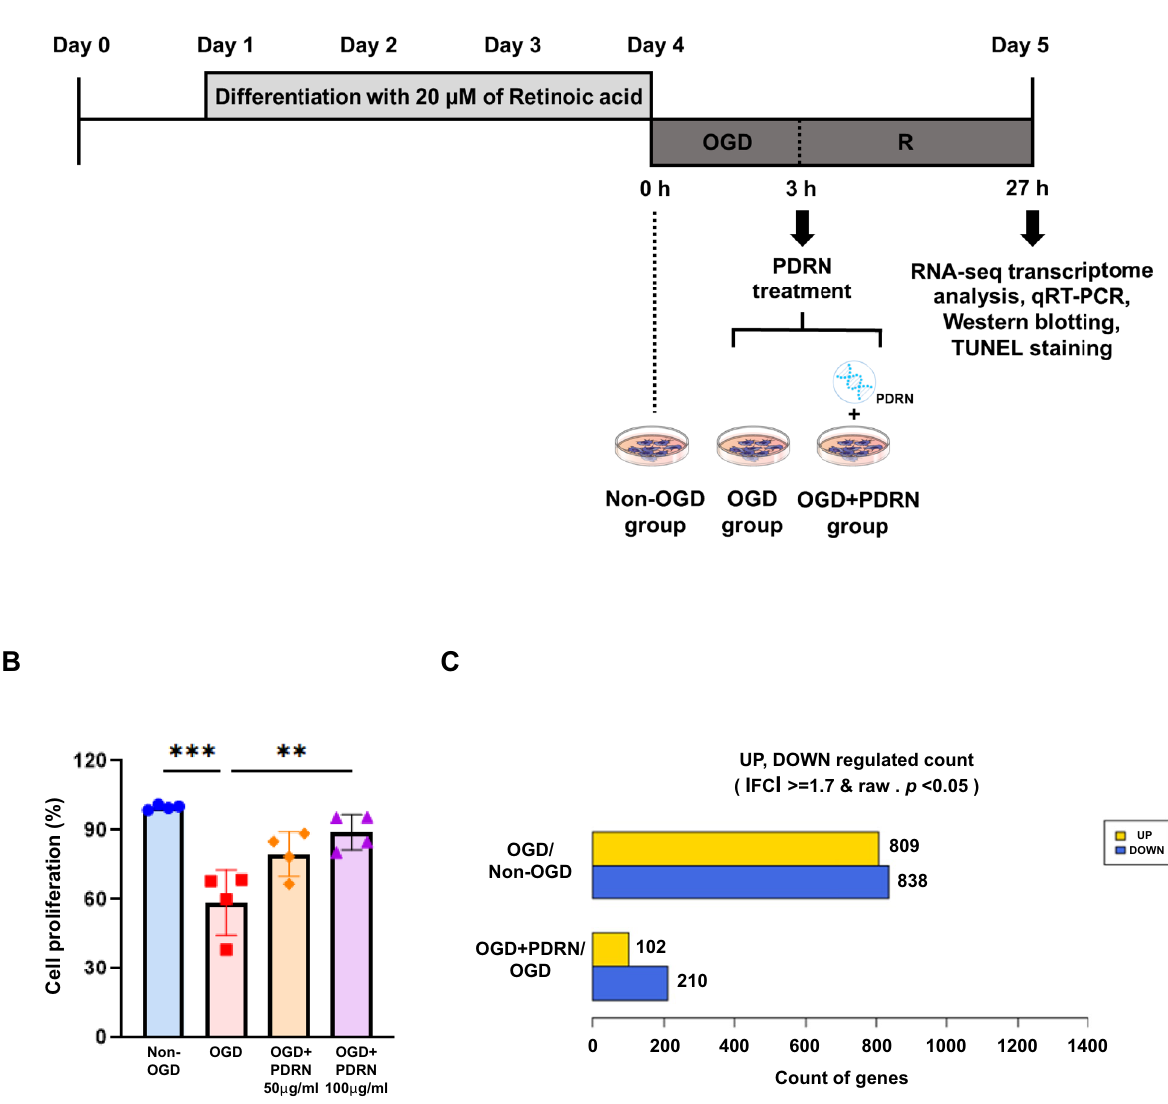
Figure 1. Effect of PDRN on an in vitro I/R injury model. ( A ) Experimental design of PDRN treatment on an in vitro I/R injury model. ( B ) Effect of PDRN on the cell viability of in vitro I/R injury model. ( C ) Bar graphs show the number of differentially expressed genes in OGD group compared with Non-OGD group and in OGD + PDRN group compared with OGD group. Values are presented as means ± standard error of the mean (SEM). Statistically significant differences are shown as ** p < 0.01, *** p <